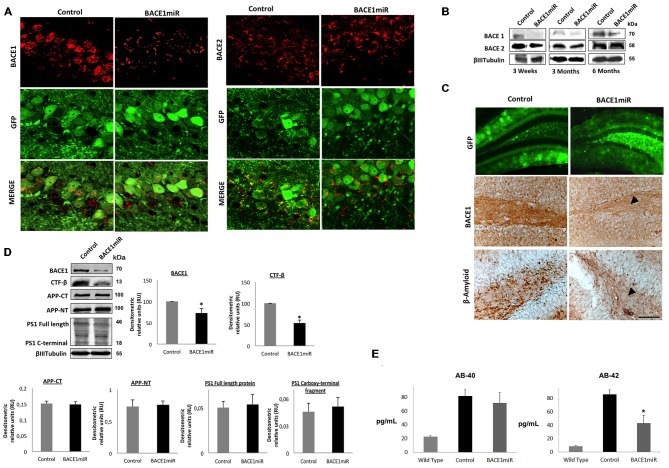
BACE1miR produces specific BACE1 silencing and reduces β-amyloidosis in 3xTg-AD mice. (A) Representative confocal images of BACE1 and BACE2 immunofluorescence in the hippocampus from wild-type mice at 6 months after injection with AAV2/5-BACE1miR compared to mice with AAV2/5-GFP injection (Control). Green: GFP fluorescence, red: Alexa 594. 60× magnification; scale bar: 20 μm. n = 3. (B) Representative immunoblots showing BACE1 and BACE2 protein levels from the hippocampi of wild-type mice at 3 weeks, 3 months and 6 months after injection with AAV2/5-BACE1miR compared to the control values (AAV2/5-GFP). n = 3. (C) β-secretase 1 (BACE1) and β-amyloid immunoreactivities in the dentate gyrus (DG) of 18-month-old 3xTg-AD mice treated with AAV2/5-BACE1miR or AAV2/5-GFP as control for 6 months. The black arrowheads show the downregulation of the BACE1 and β-A immunostaining. Green: GFP fluorescence, adeno-associated virus (AAV) distribution in the DG. 40×, scale bar: 20 μm. n = 3. (D) Representative immunoblots showing BACE1, the C-terminal fragment (CTF-β), APP-CT, APP-NT, full-length PS1 and the C-terminal fragment of PS1 from the hippocampi of 18-month-old 3xTg-AD mice evaluated at 6 months after injection of AAV2/5-BACE1miR or AAV2/5-GFP as a control. RU = relative units. n = 4, *p < 0.05. (E) β-amyloid 1–40 and 1–42 levels from the hippocampi of 18-month-old 3xTg-AD mice were evaluated by ELISA at 6 months after the injection of AAV2/5-BACE1miR or AAV2/5-GFP; C57BL/6 mice were also used as controls. Absorbance was measured at 620 nm. n = 5, *p < 0.05.